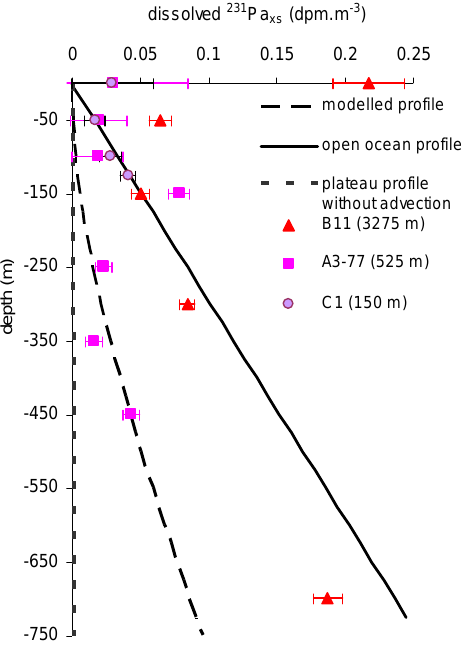
Fig. 6. Advection-scavenging model applied to dissolved 231 Pa xs . The symbols represent the measured dissolved 231 Pa xs profiles at KEOPS stations. The lines represent: dashed line (scavenging model with advection on the plateau – A3 station – of open-ocean water with 231 Pa xs concentration increasing with depth), solid bold line (the imposed open-ocean dissolved 231 Pa xs profile: B11 cho- sen here as reference) and dotted line (dissolved 231 Pa xs profile without advection). Dissolved 231 Pa xs concentrations at C1 station are also represented, since they may be representative of advected waters from the south of the Kerguelen plateau (south of Heard Is- land). Error bars are represented at the 2 σ value. Bottom depths are indicated into